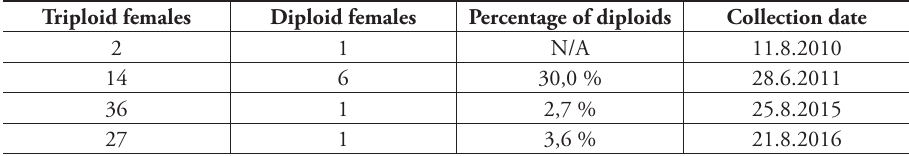
Table 3. Number of diploid and triploid females with sperm in their spermathecae. Number of females checked triploid diploid